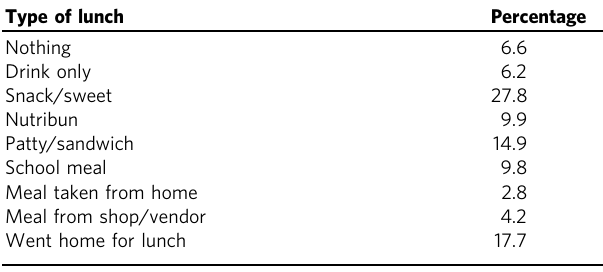
Table 4 Type of lunch consumed by school